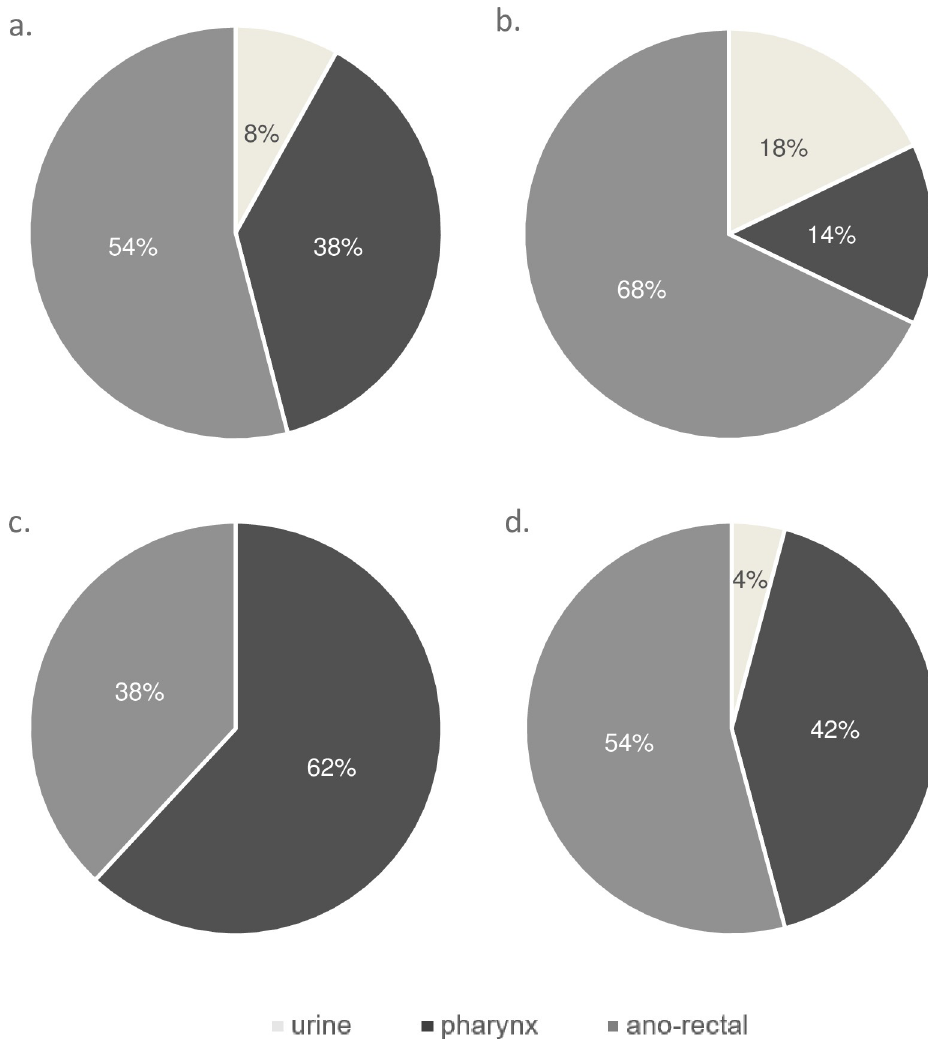
C. trachomatis during period 1 (a.) and 2 (b.) and N. gonorrhea during period 1 (c.) and 2